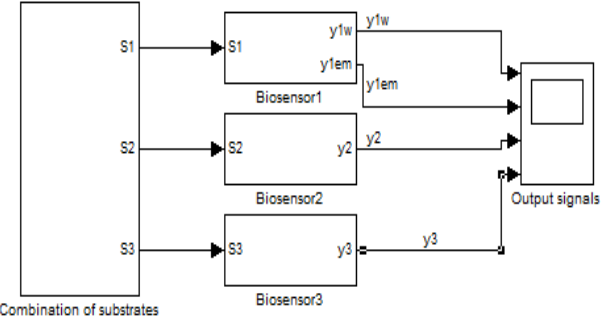
Fig. 11. The curve of control system without adaptation. The curve of x out with F1 = 10 and the function of adapter1 W adapt1 = k 1 = 2 is shown in Fig. 12.